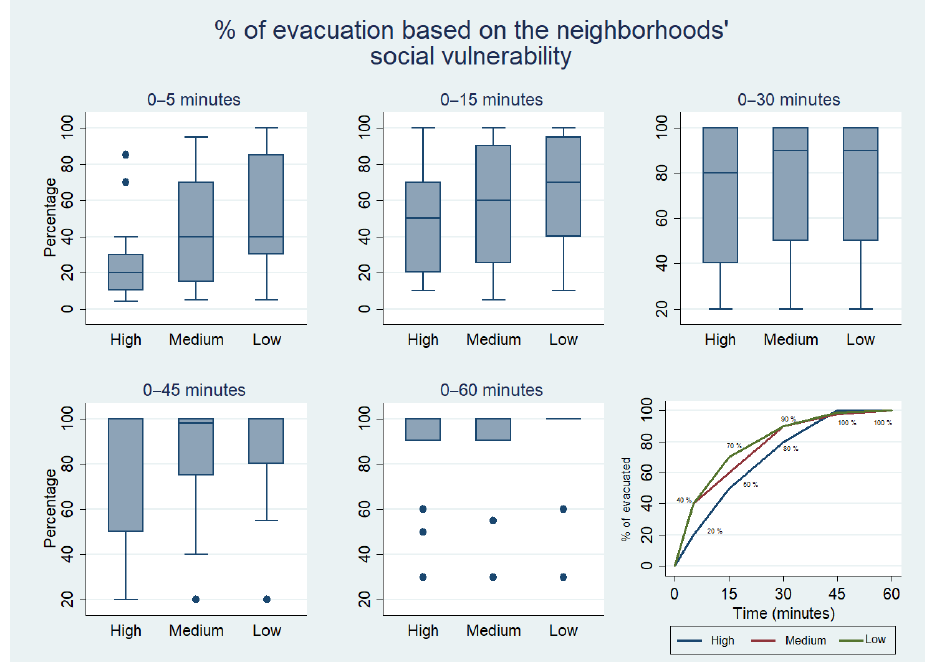
Figure 5. First responder results by social vulnerability